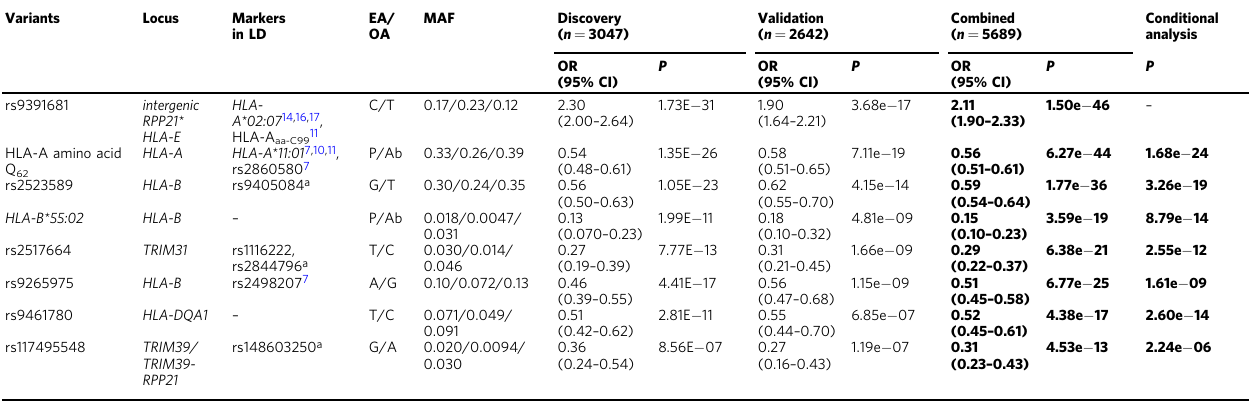
Table 1 Association results of eight independent variants of NPC genetic susceptibility in discovery, validation, and combined